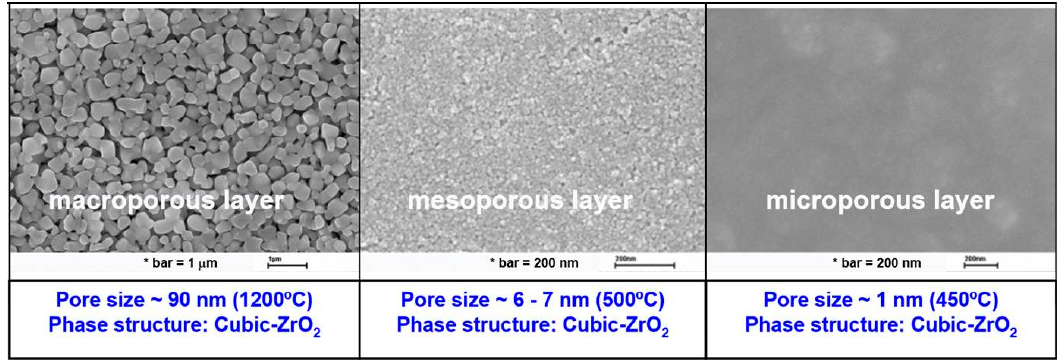
Figure 5. SEM image of three types of ceramic membrane with ZrO 2 support. Reproduced with permission from [51].